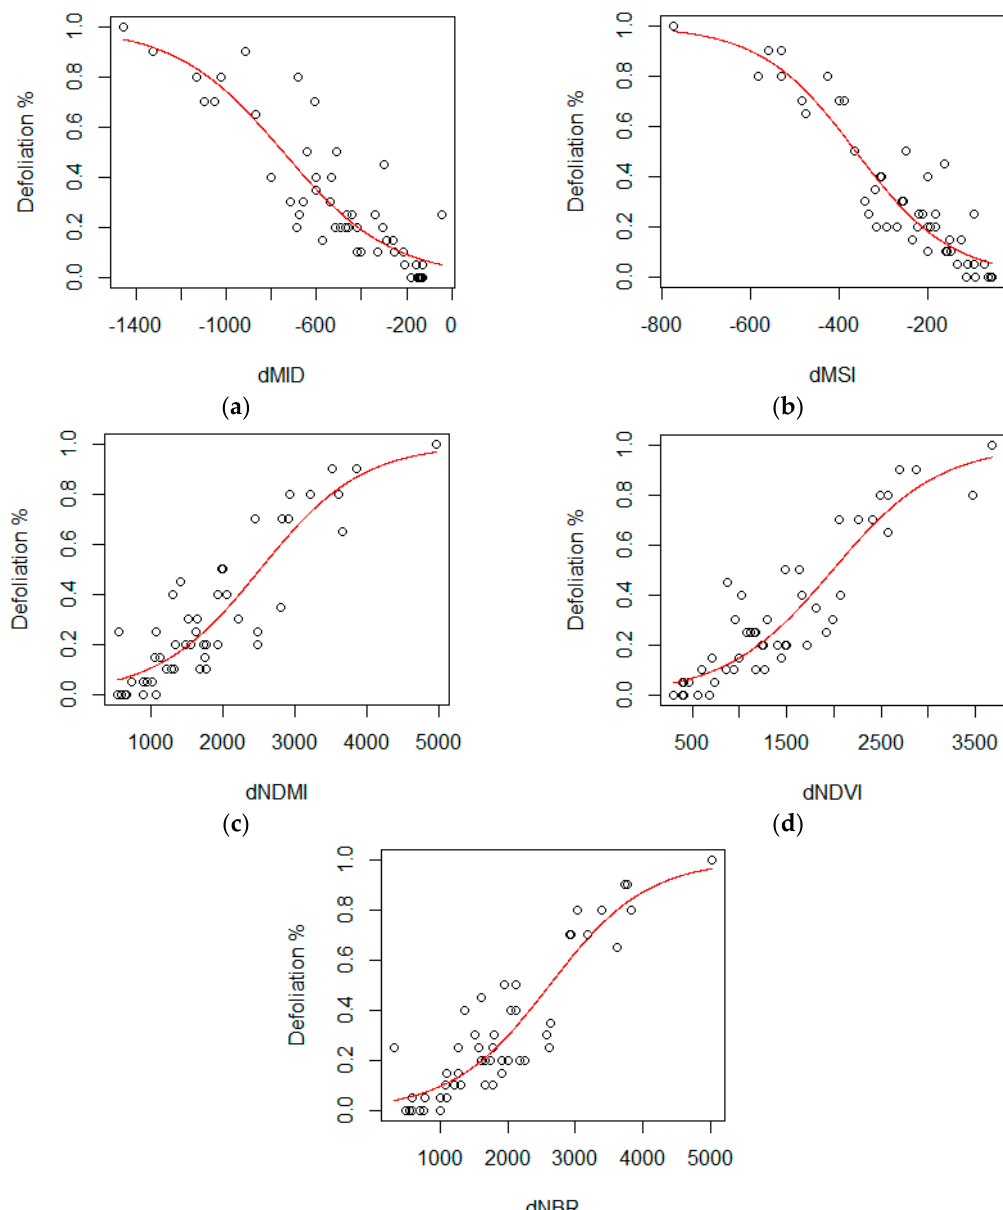
Figure 3. Scatterplots of defoliation (%) as response variable and dVI as predictor variable: ( a ) dMID;